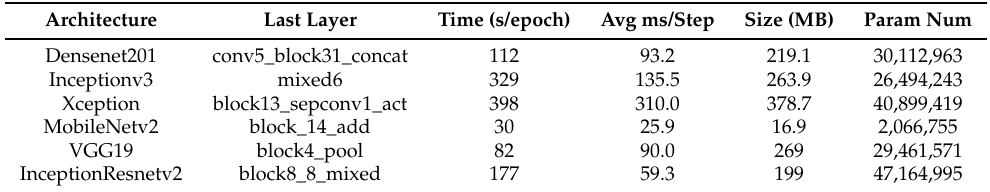
Table 6. Classification models specification in terms of training time and size for models with the best result in present